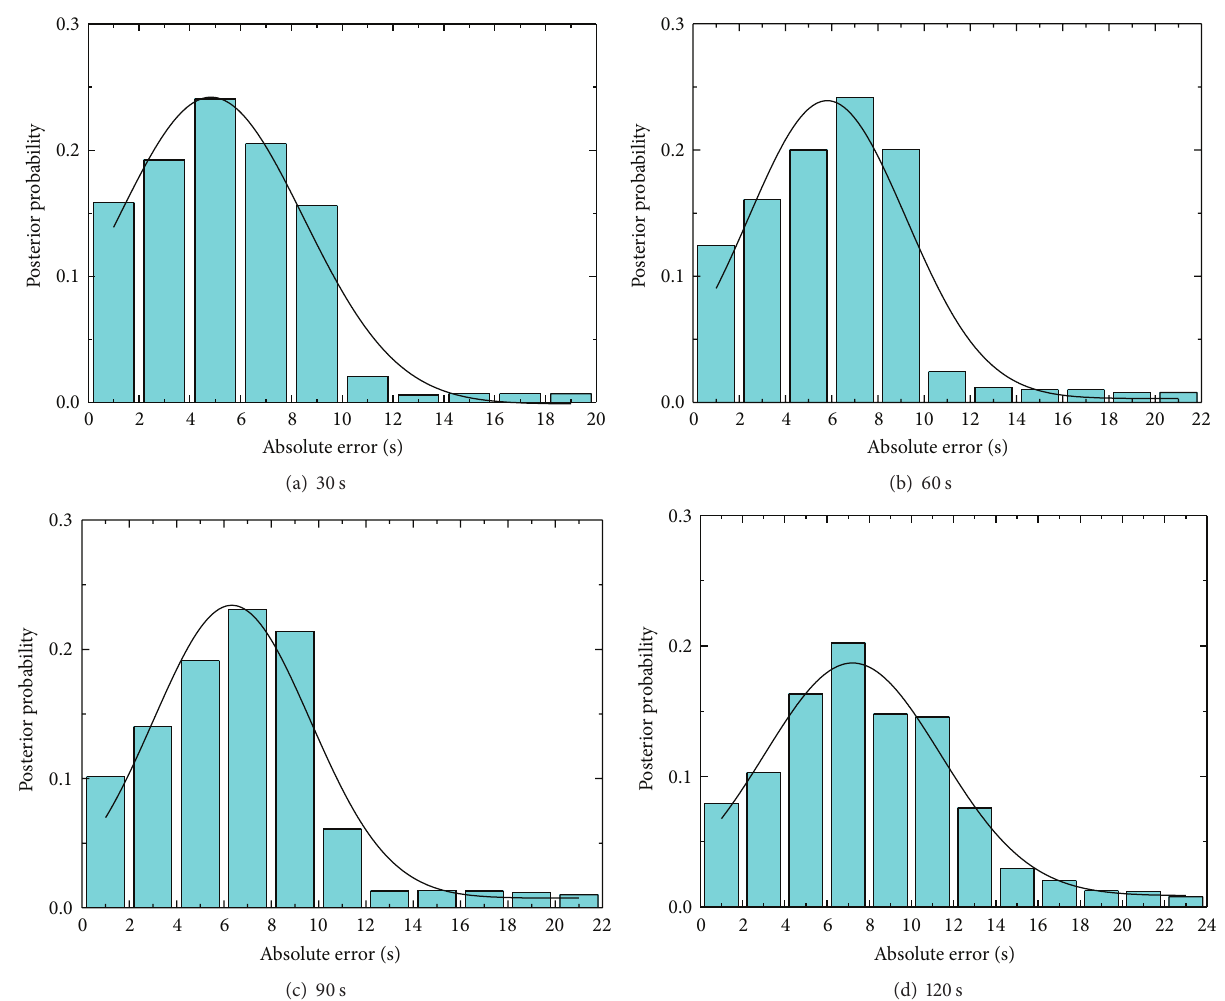
Figure 10: A posteriori distribution of the absolute error based on the proposed method at different sampling